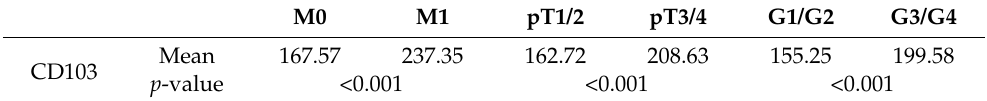
Table 9. TCGA CD103 Expression (Mann–Whitney U test, TCGA KIRK cohort, n = 436